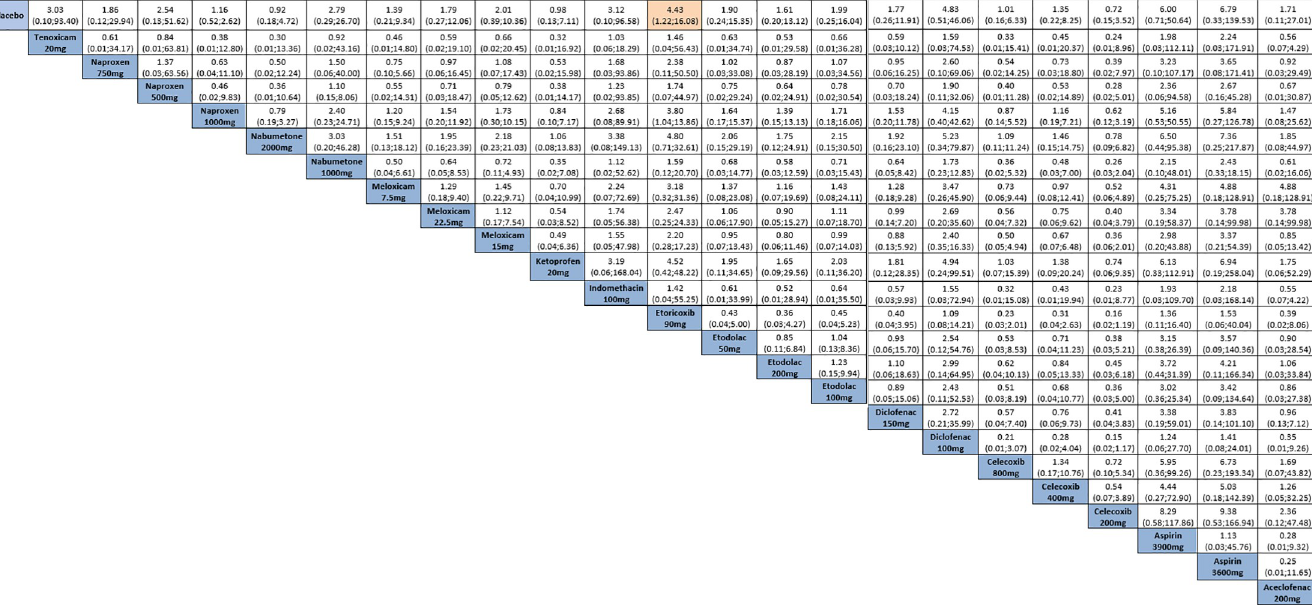
Fig 6. Comparative adverse events between drugs using network meta-analysis. Comparisons should be read from left to right. Odds ratio for comparisons are located in the common cell between the column-defining and row-defining treatment. Numbers on highlighted background are statistically significant.